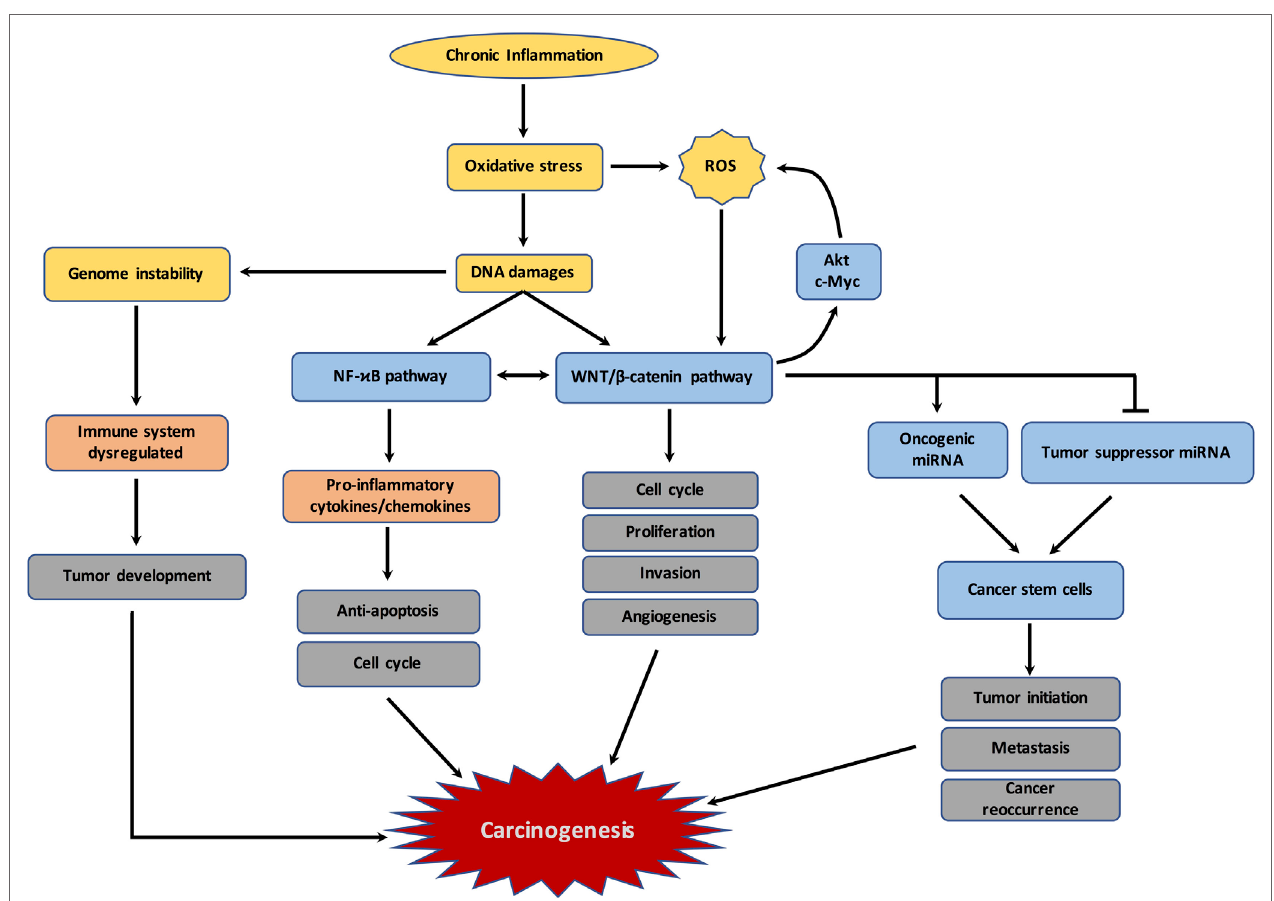
FiGURe 2 | Schematic representation of the links between chronic inflammation, oxidative stress, DNA damages and carcinogenesis. The figure represents the different mechanisms involved by chronic inflammation and resulting in dysregulation of immune response, reactive oxygen species (ROS) production, DNA damages, and subsequently the initiation of